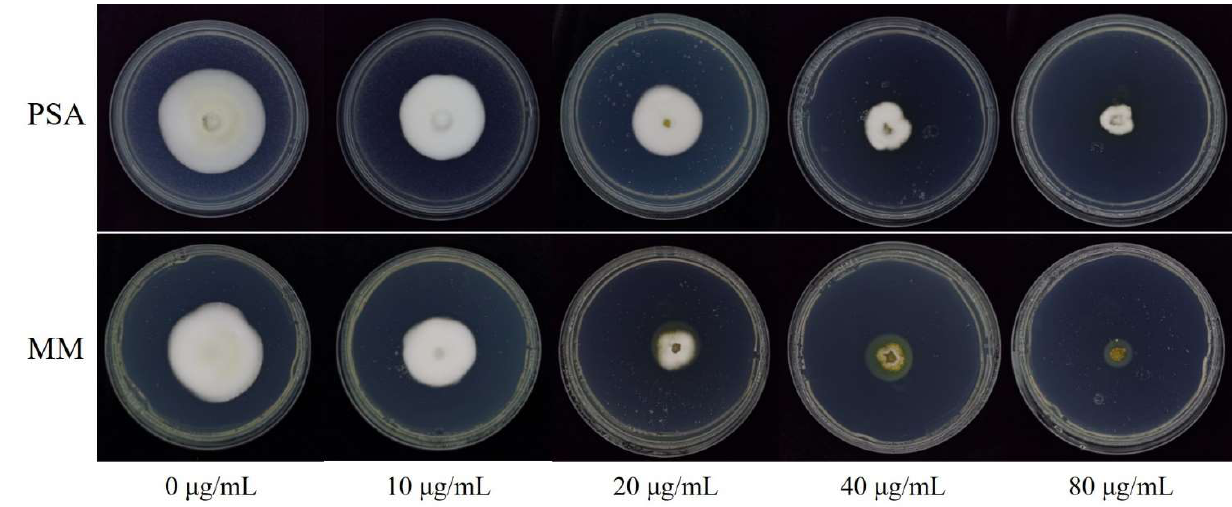
Figure 1. Effects of SHAM at different concentrations on mycelial growth of Ustilaginoidea virens isolate HWD on PSA and MM. Photos were taken after 21 days of incubation at 27 °C in the dark. PSA, potato sucrose agar; MM, minimal medium.